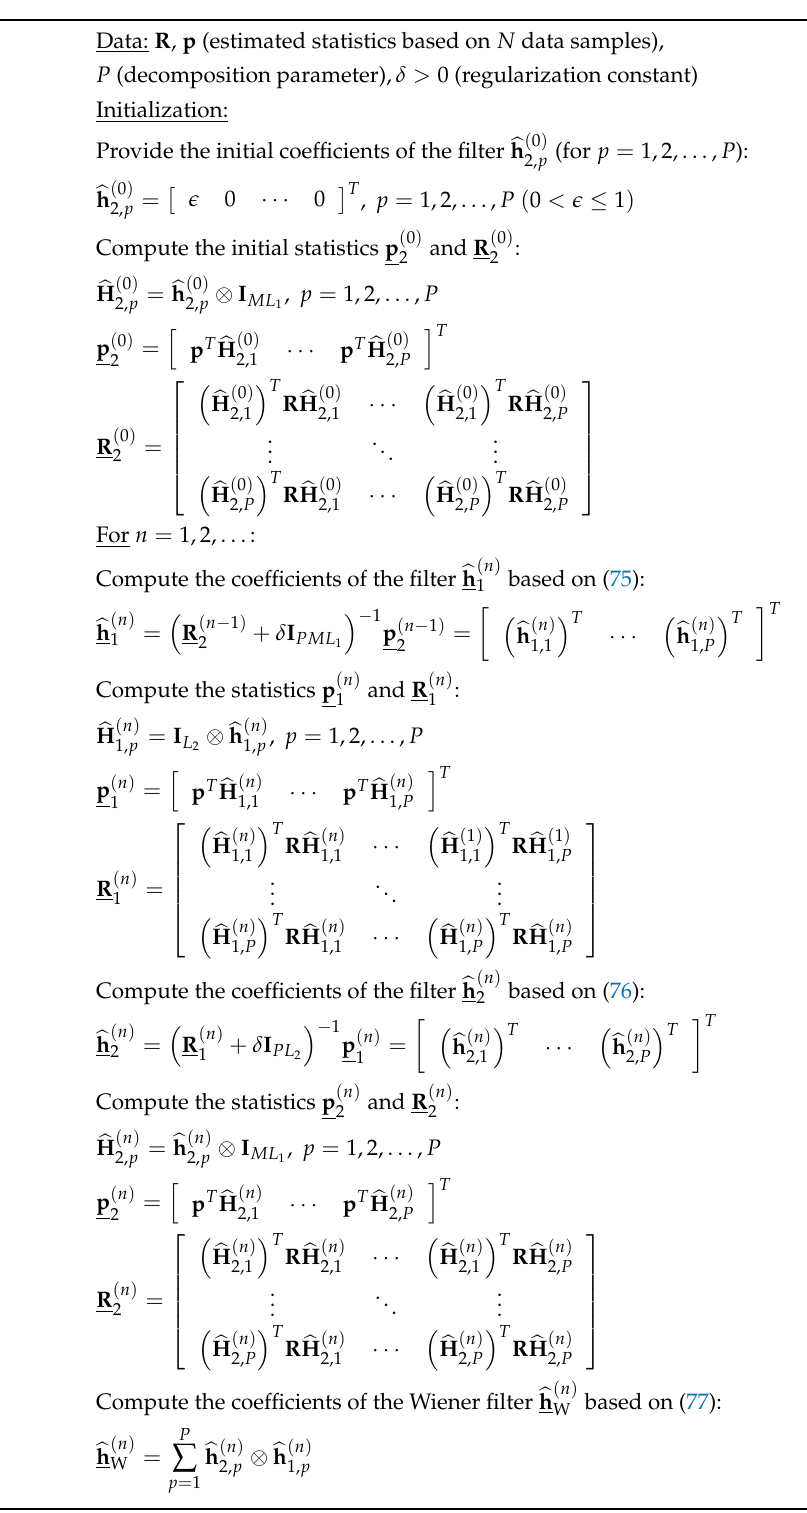
Table 1. The multichannel iterative Wiener